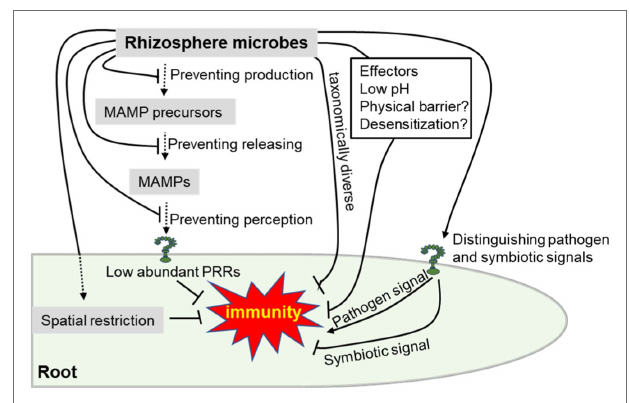
FIGURE 2 | Schematic overview of plant and rhizosphere microbes that evade or suppress root immune responses as described in the main text. Briefly, beneficial microbes can suppress plant immune response by evading pattern recognition receptor (PRR) recognition of MAMPs, taxonomically diverse, secreted effectors, low pH, physical barrier, desensitization and symbiosis-related molecules. On the other hand, plants could also suppress root immune responses by immune spatial restriction, low abundant PRRs and precisely distinguishing between the pathogen and beneficial microbes. Beneficial rhizosphere microbes can evade or suppress root immunity, suggesting that this is a useful trait for rhizosphere